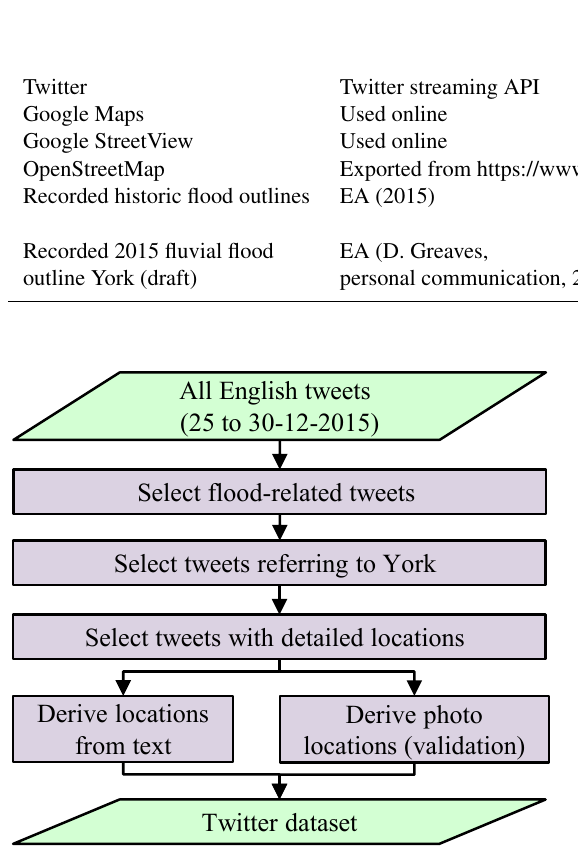
Figure 2. Process of constructing the dataset of